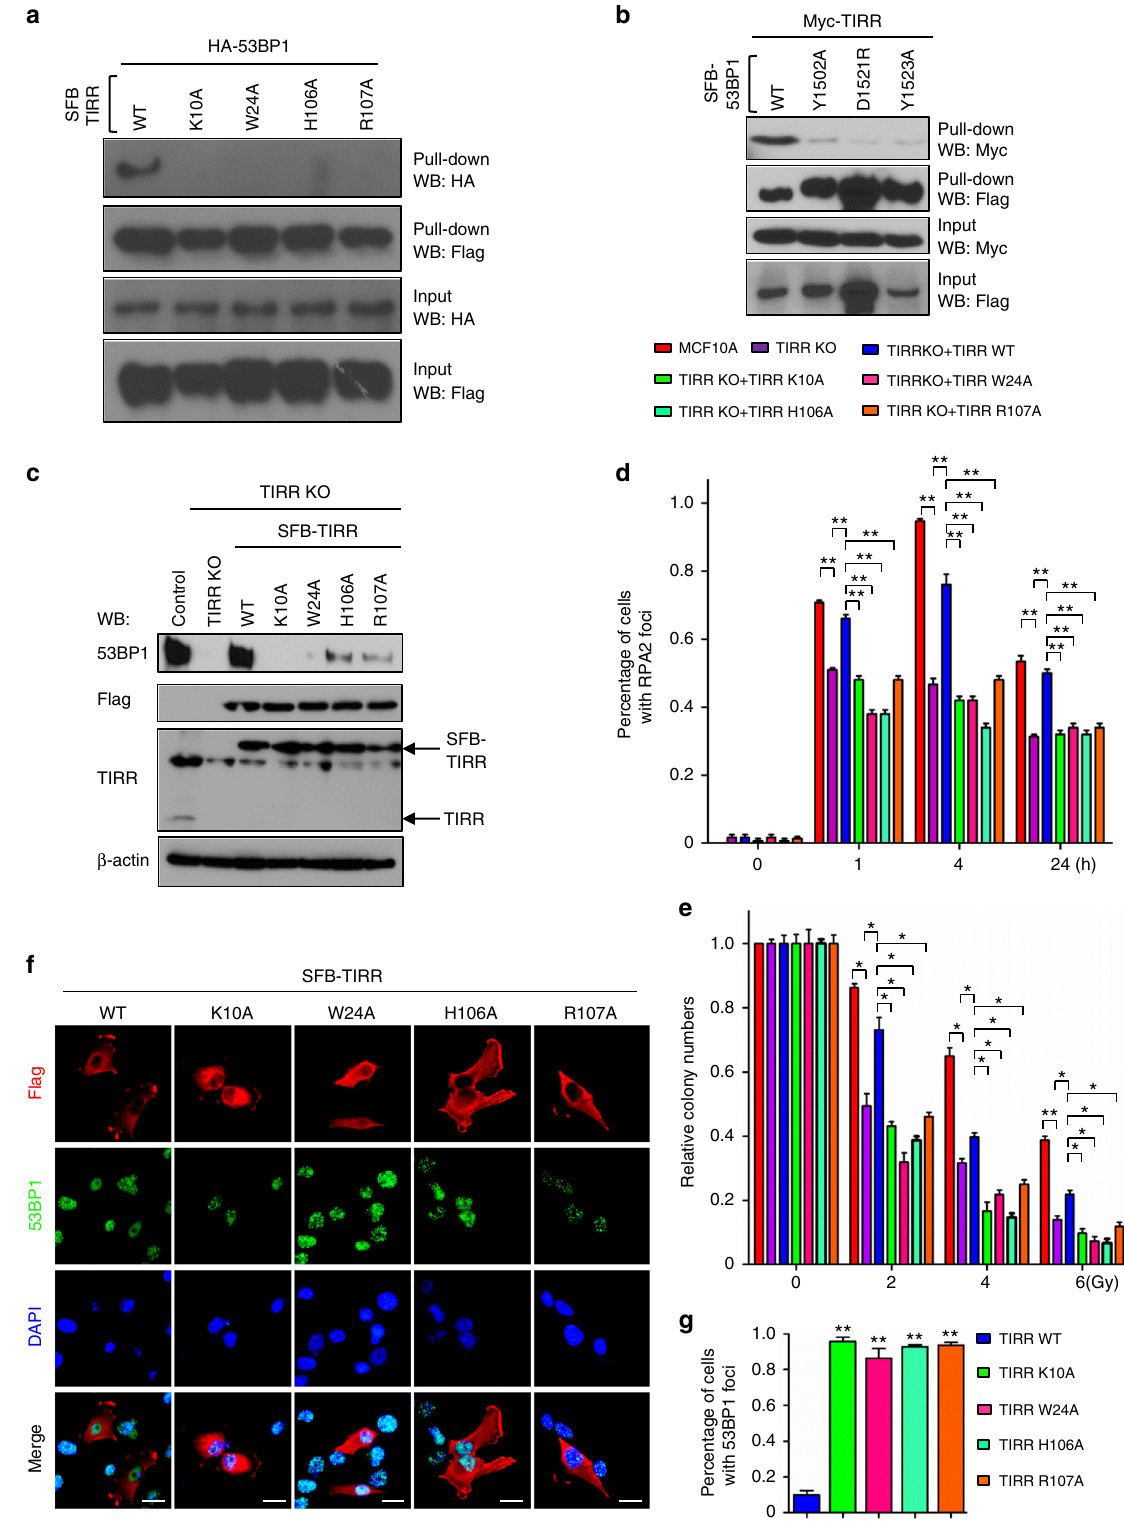
initial search model. The COOT 26 and PHENIX 27 were used for manual model building and re fi nement, whereas PROCHECK 28 was used for model geometry veri fi cation. The fi nal structure of this complex was re fi ned to 1.76Å resolution, against R work / R free = 0.20/0.22. The statistics for data collection and structural re fi nement are summarized in Table 1, and fi gures were prepared with PyMOL (http://www.pymol.org/).